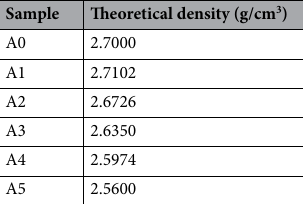
Table 3. Theoretical density of the fabricated samples.